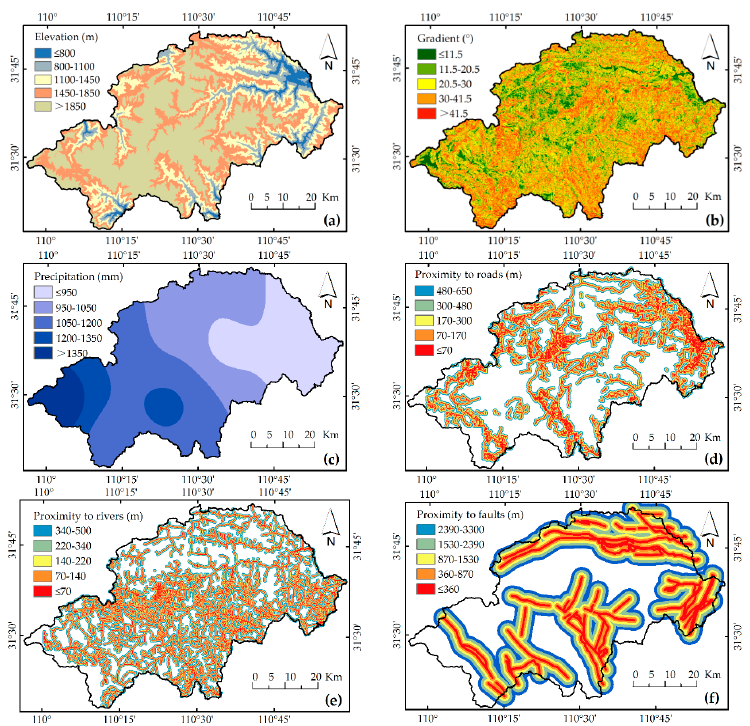
Figure 4. Input layers of influence factors: ( a ) elevation; ( b ) gradient; ( c ) precipitation; ( d ) proximity to roads; ( e ) proximity to rivers; and ( f ) proximity to faults (produced using ArcGIS 10.2).